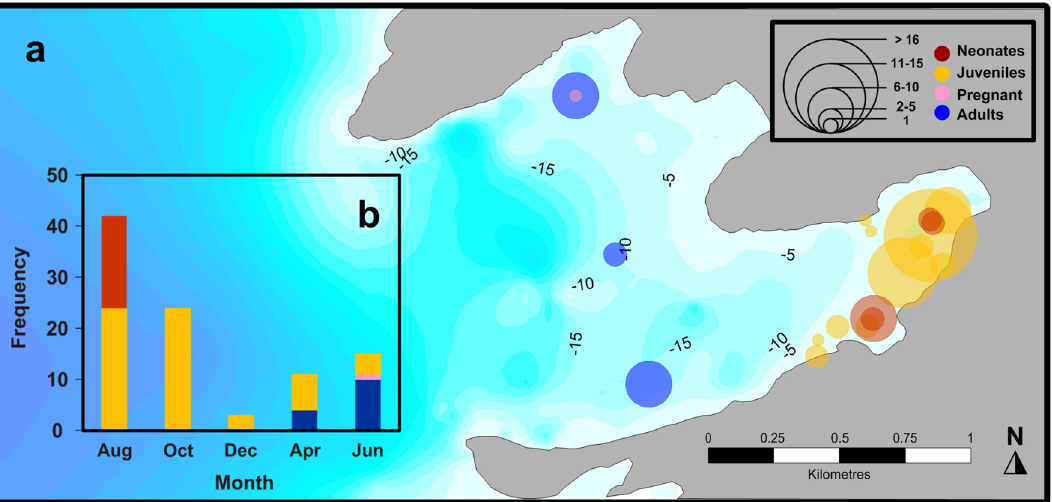
Figure 2. ( a ) Capture locations of M. munkiana between August 2017 and June 2018 at Ensenada Grande. Circle size indicates the number of individuals captured at each location by life stage. Numbers indicates the